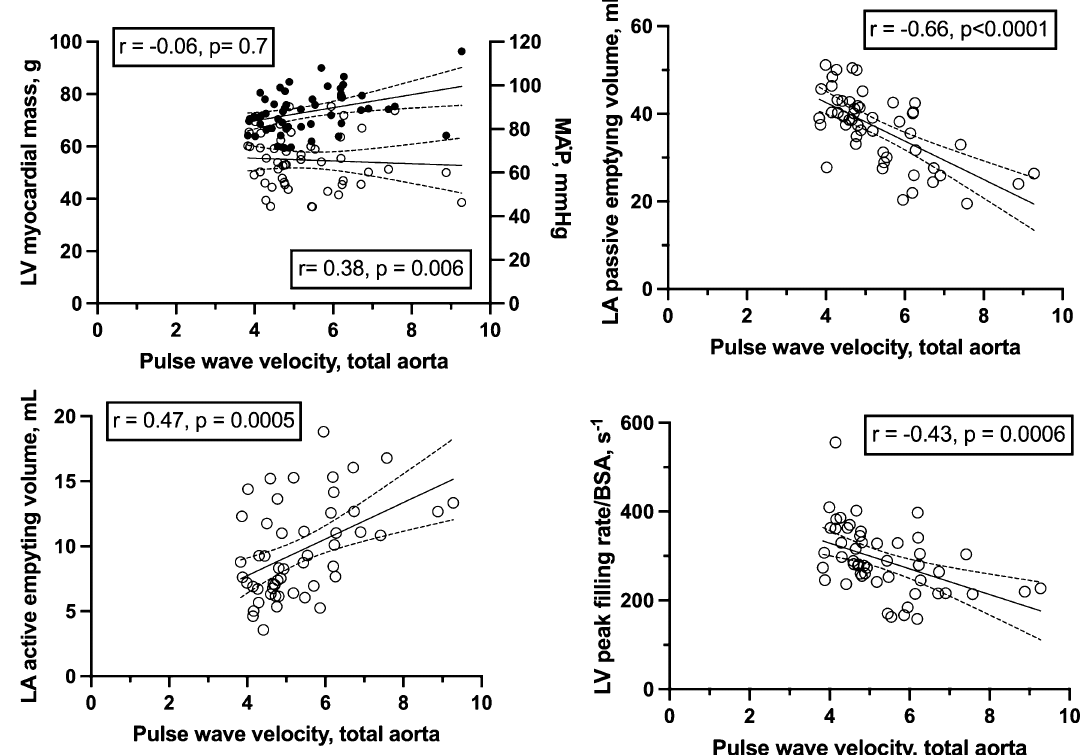
Figure 1. Upper left, left ventricular (LV) myocardial mass (circles, left axis) and mean arterial pressure (MAP; solid circles, right axis) to total aortic pulse wave velocity (circle) as determined from CMR time-volume curves in 36 healthy young and 16 healthy middle-aged subjects. Lower left, left atrium (LA) active emptying volume to total aortic pulse wave velocity. Upper right, LA passive emptying volume to total aortic pulse wave velocity. Lower right, indexed LV peak filling rate to total aortic pulse wave velocity. Total aortic pulse wave velocity is correlated to LV peak filling rate (r = − 0.47) and both LA passive (r = − 0.66) and active emptying volumes (r = 0.47) (all p < 0.05).